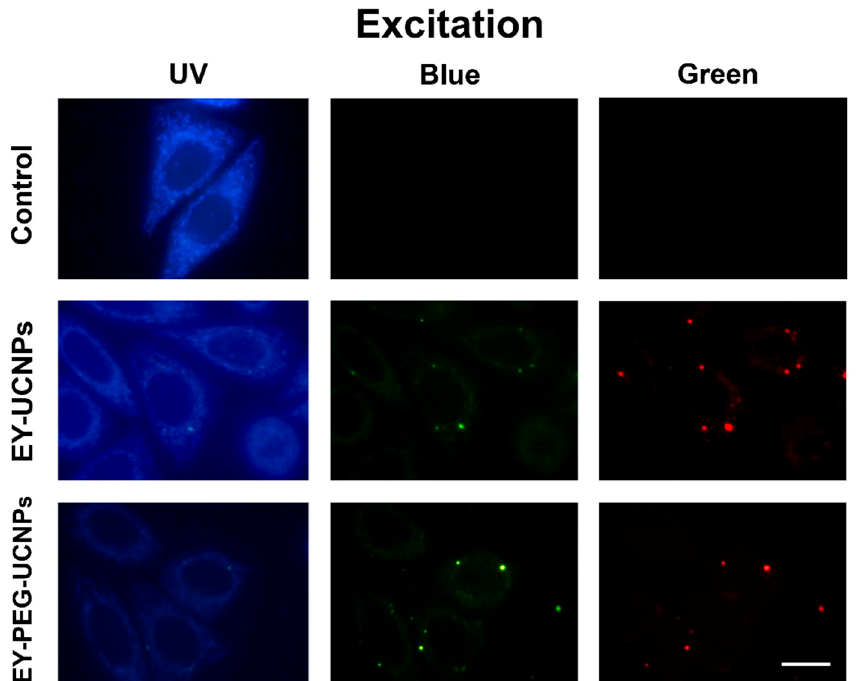
Figure 4. Subcellular localization of EY-UCNPs and EY-PEG-UCNPs in HeLa cells by fluorescence microscopy. Cells were incubated with EY-UCNPs conjugates and illuminated with UV, blue, and green light in the epifluorescence microscope. Scale bar: 10 µ